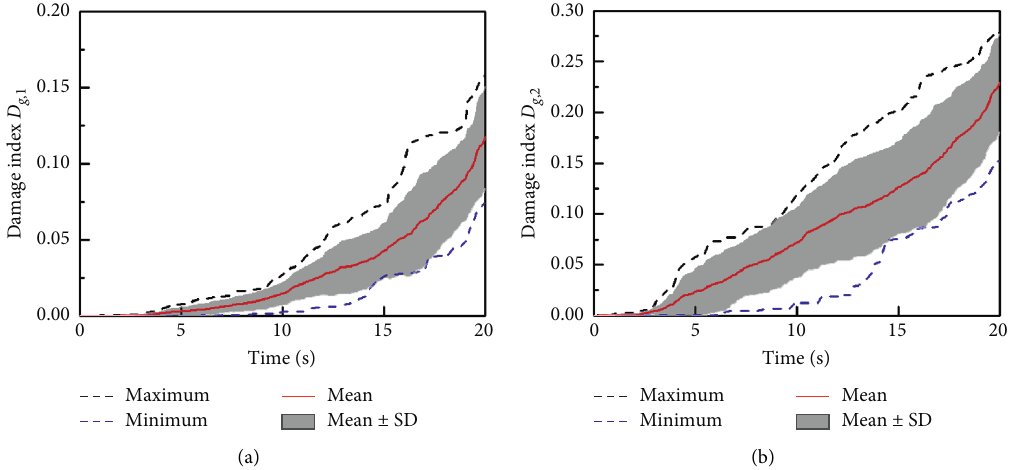
Figure 12: Fragility damage indices at different intensities: (a) D